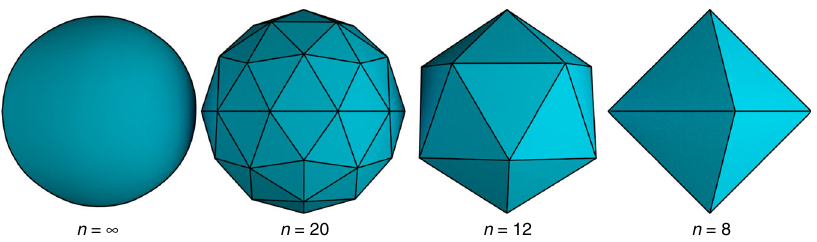
Fig. 2 Triangulation of surfaces. Any curved surface, in this case a sphere, can be approximated by a mesh of triangles in a process called triangulation. A larger mesh of triangular faces gives a better approximation of the original surface. Shown are polyhedral triangulations of a sphere with n triangular faces